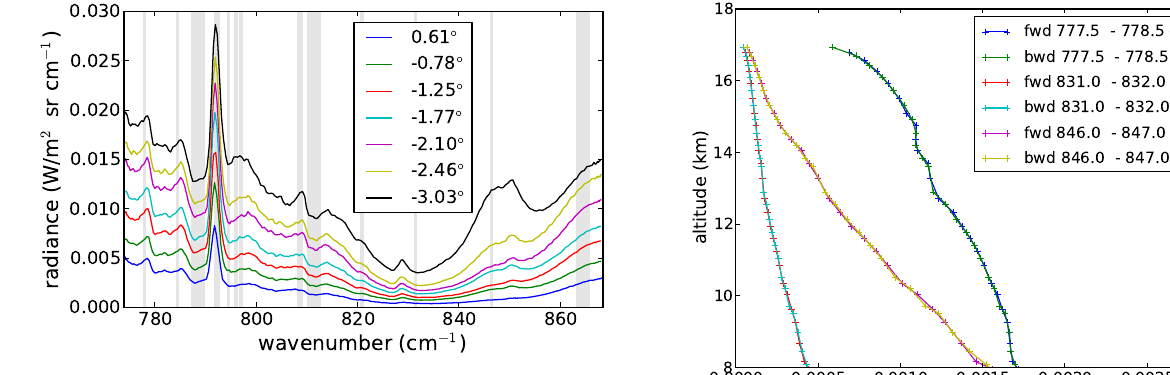
Fig. 1. Seven representative calibrated spectra as measured by the LRS6 detector at different elevation angles (negative angles point downward). The frequency ranges of the IMWs used for the retrieval are shown as grey boxes. With an observer altitude of 19.1km, the angle of − 0.78 ◦ corresponds to a tangent point altitude of 18.41km while the angle of − 3.03 ◦ corresponds to a tangent altitude of 10.1km.